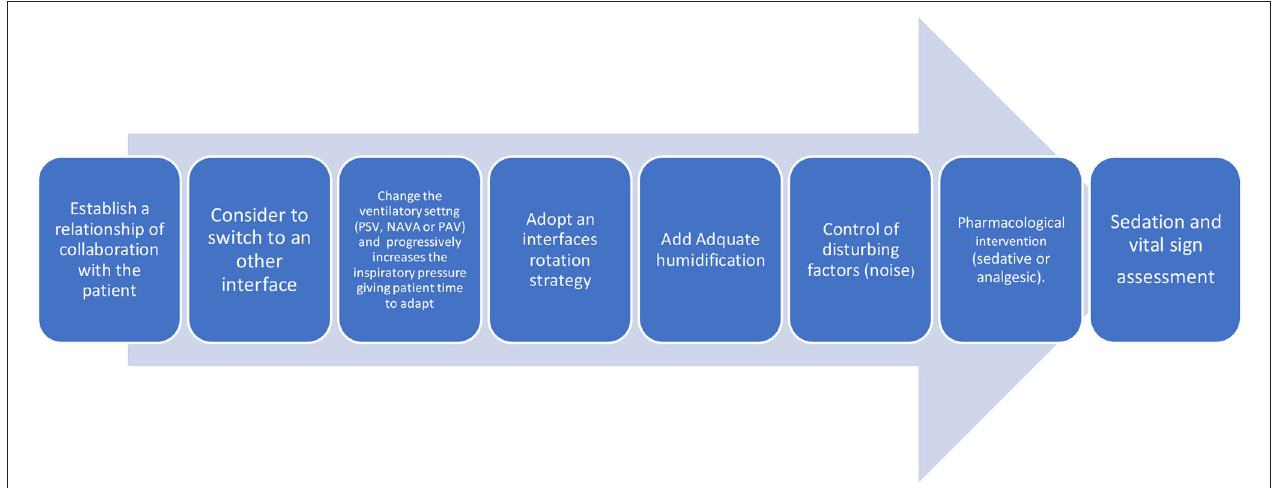
FIGURE 1 | Patient intolerance bundle of